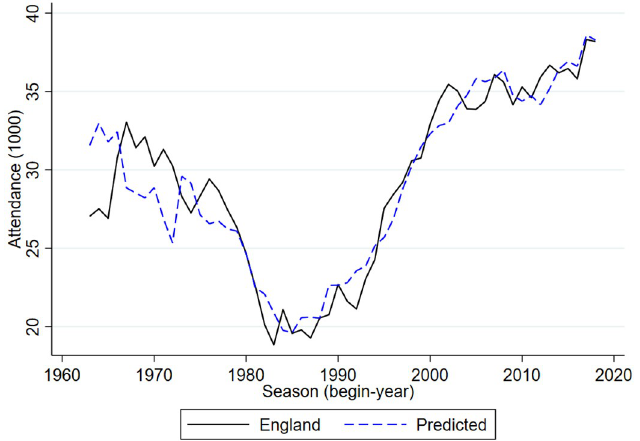
Fig 6. Stadium attendance professional football England; actual and predicted attendance; 1963/64-2018/19